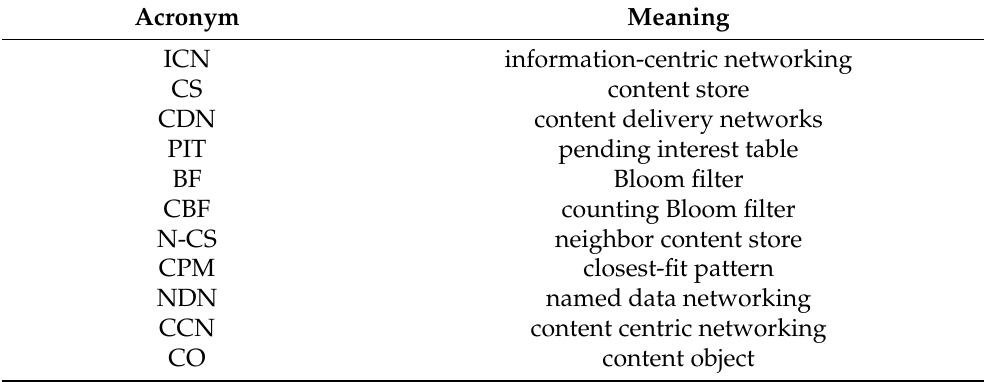
Table 1. List of